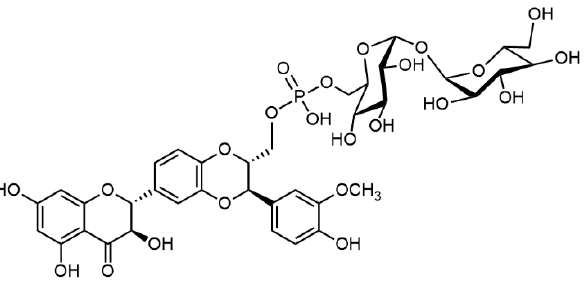
Figure 8. Structure of silybin A conjugate with trehalose linked via phosphate diester bond [102].